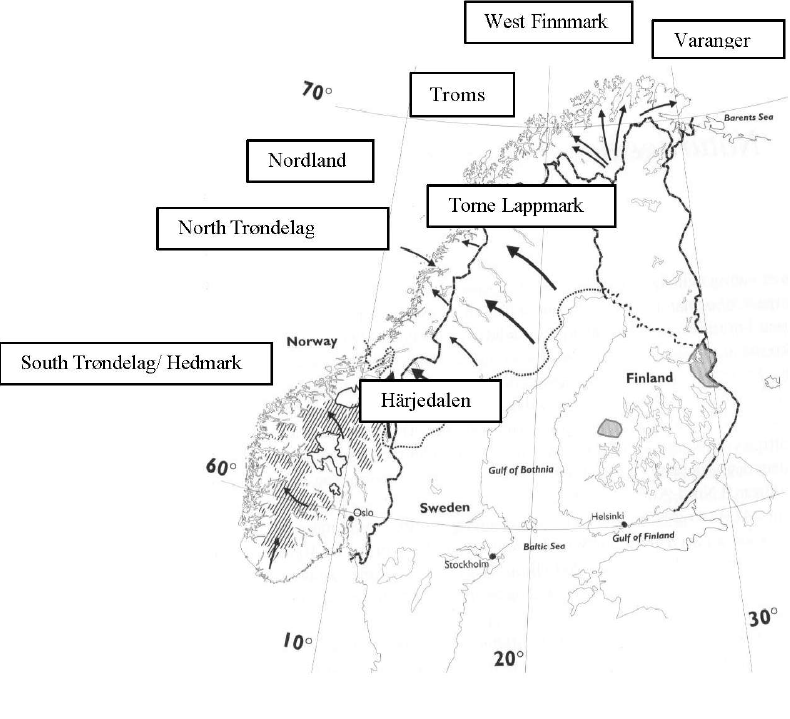
Fig. 11. Reindeer management areas of Fennoscandia. From Gaare